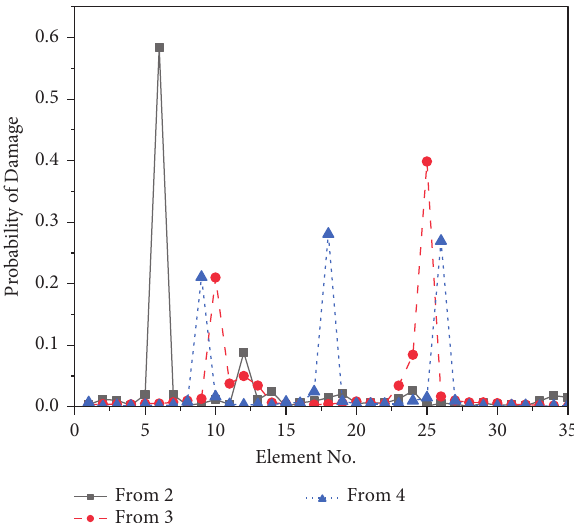
Figure 34: Recognition results of the second-level fusion